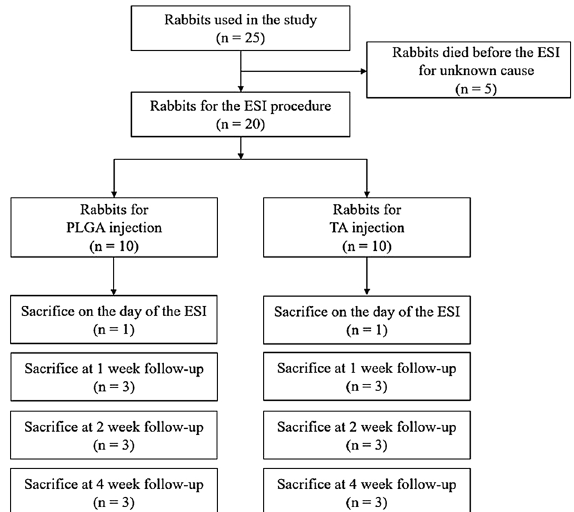
Figure 1. Schematic diagram of the study design. Flow diagram showing the study